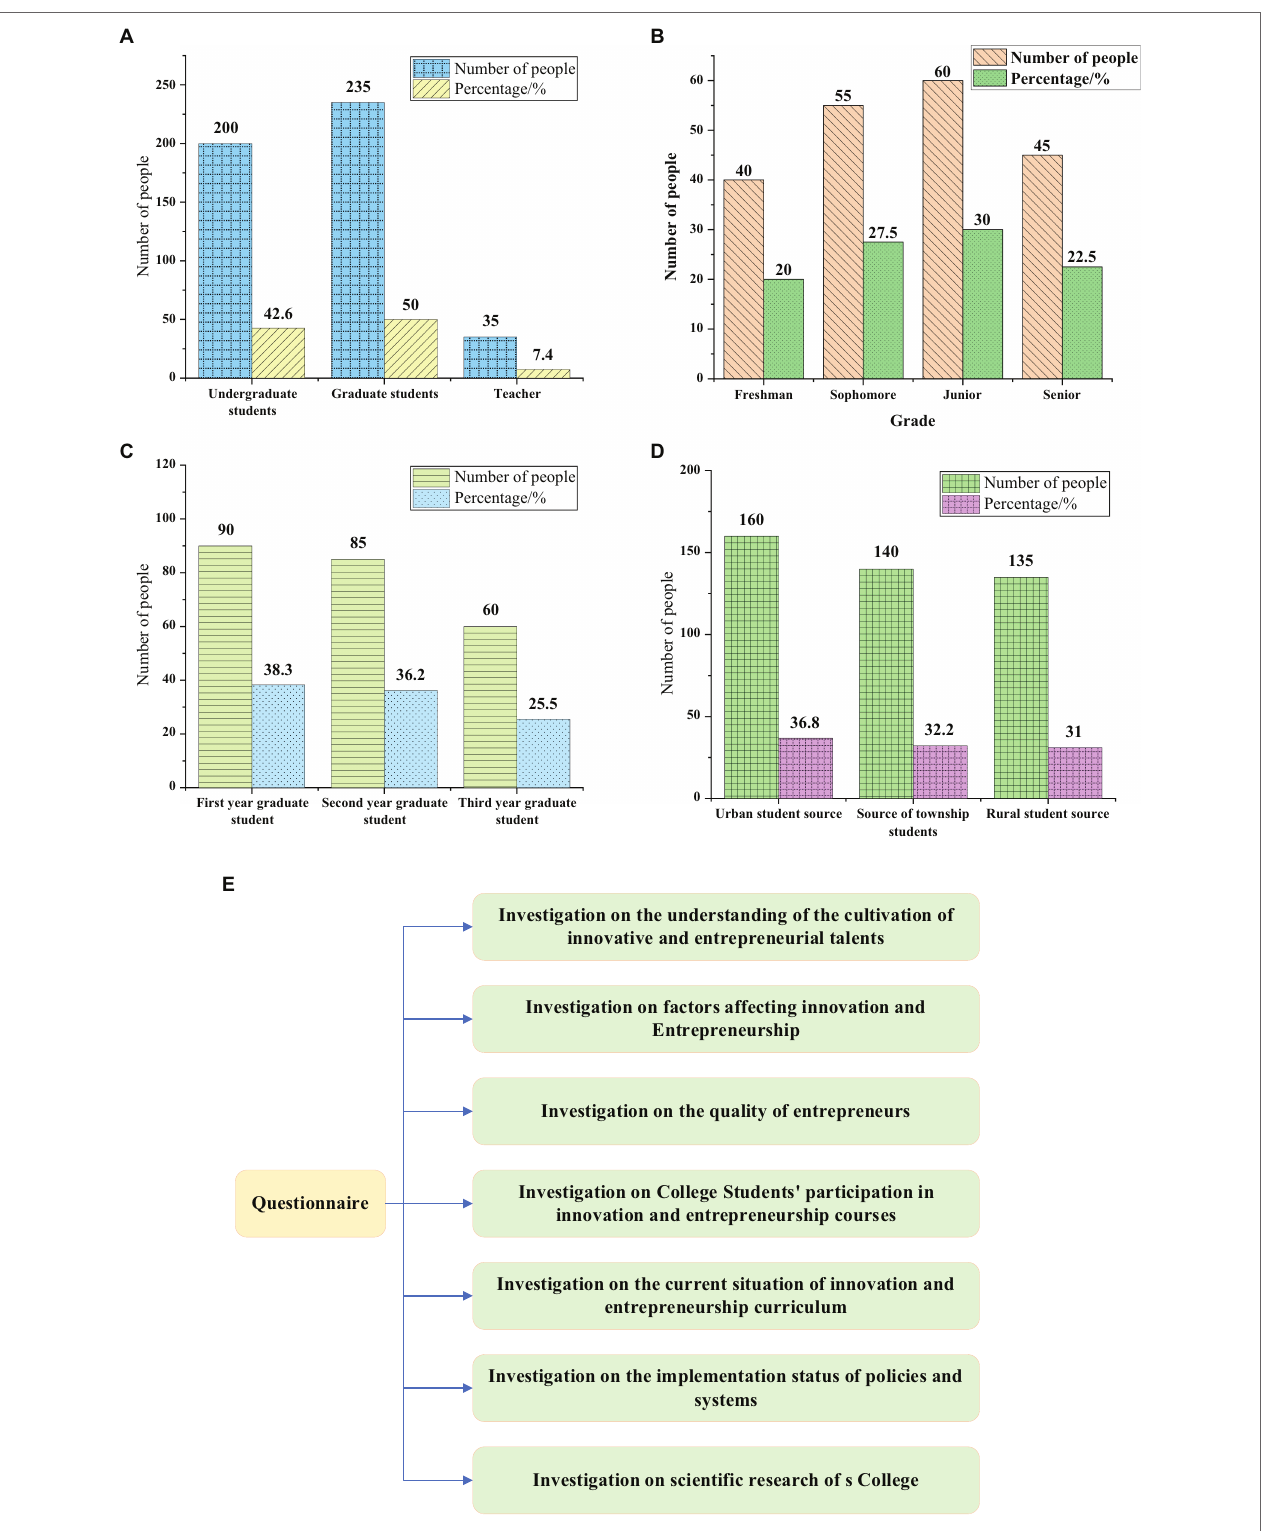
FIGURE 5 | Information of respondents. (A) Distribution of undergraduates, graduate students, and teachers. (B) Distribution of undergraduate students in different grades. (C) Distribution of graduate students in different grades. (D) Distribution of students in different locations of their home. (E) Content structure of the